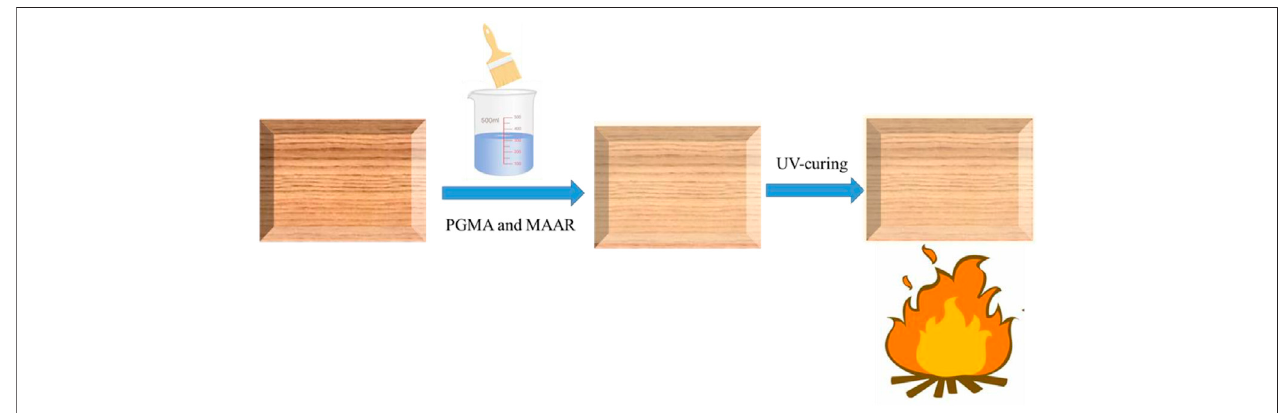
FIGURE 1 | Schematic of preparation of different